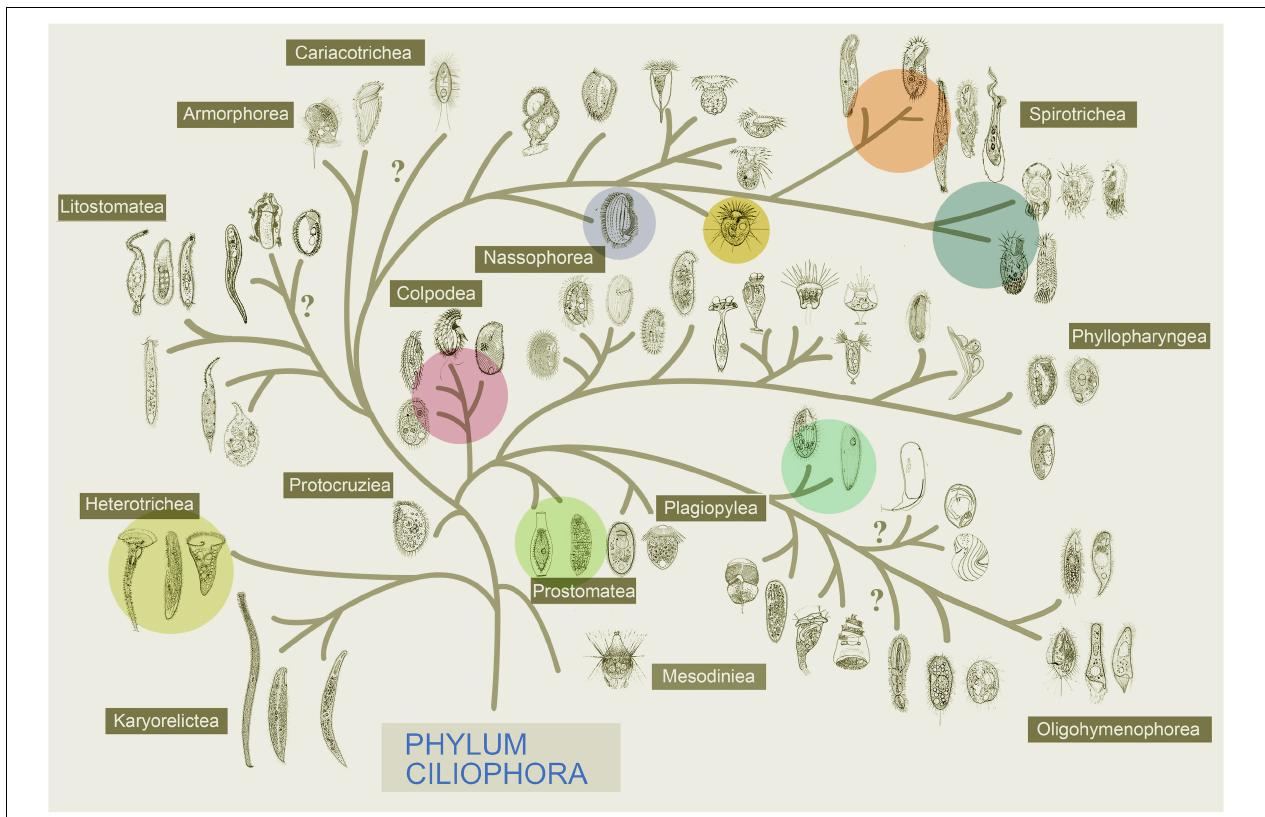
FIGURE 3 | Systematic positions of the 14 species described in Figure 2 , of which 5 classes within the phylum Ciliophora are represented (marked in color, modified after Gao et al., 2016).